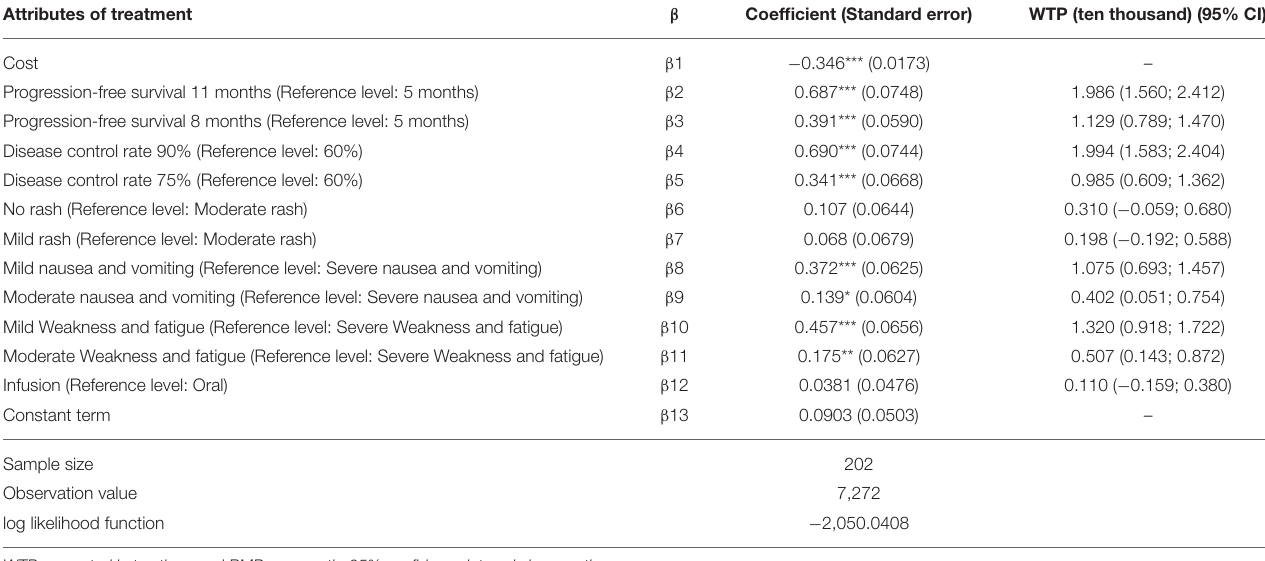
TABLE 6 | Regression results and WTP.